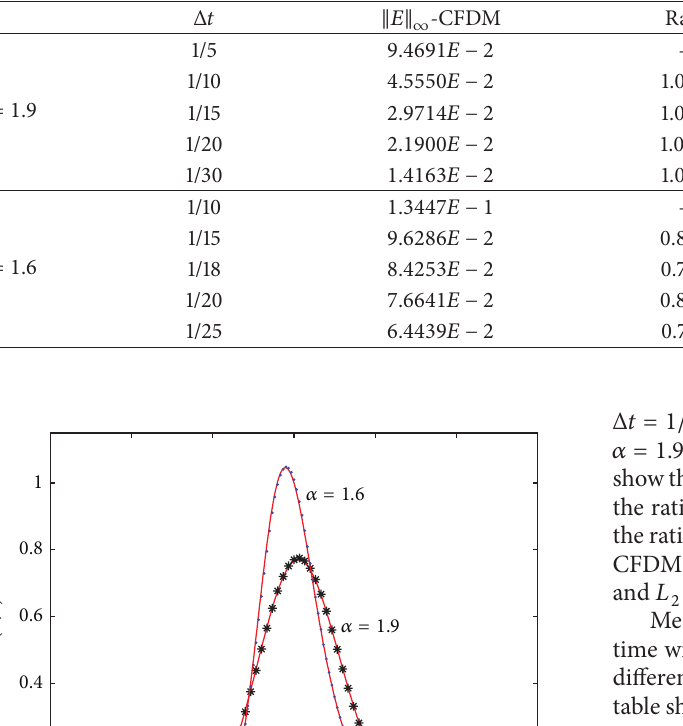
Table 2: The errors and ratios in time calculated by CFDM (12) with 𝑑 = 0.02 and Δ𝑥 = 1/300 at time 𝑡 = 1.5 , for two different fractional orders 𝛼 = 1.9 and 1.6, respectively.